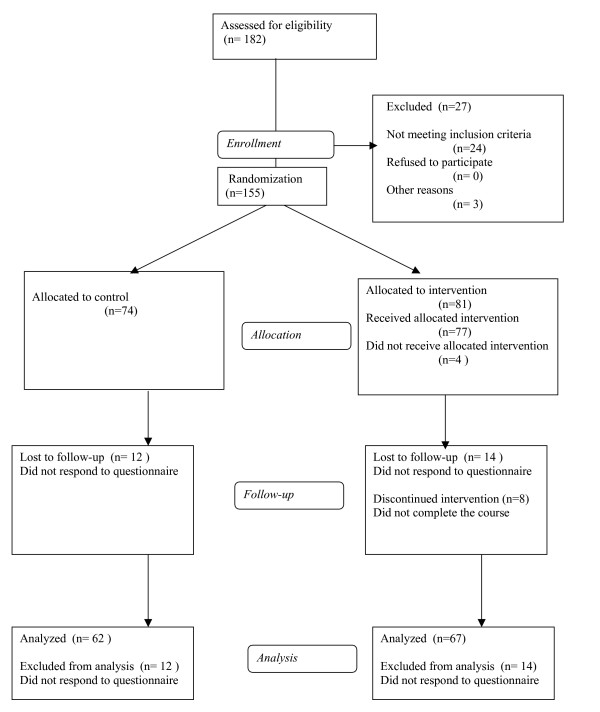
Flow chart of participants.